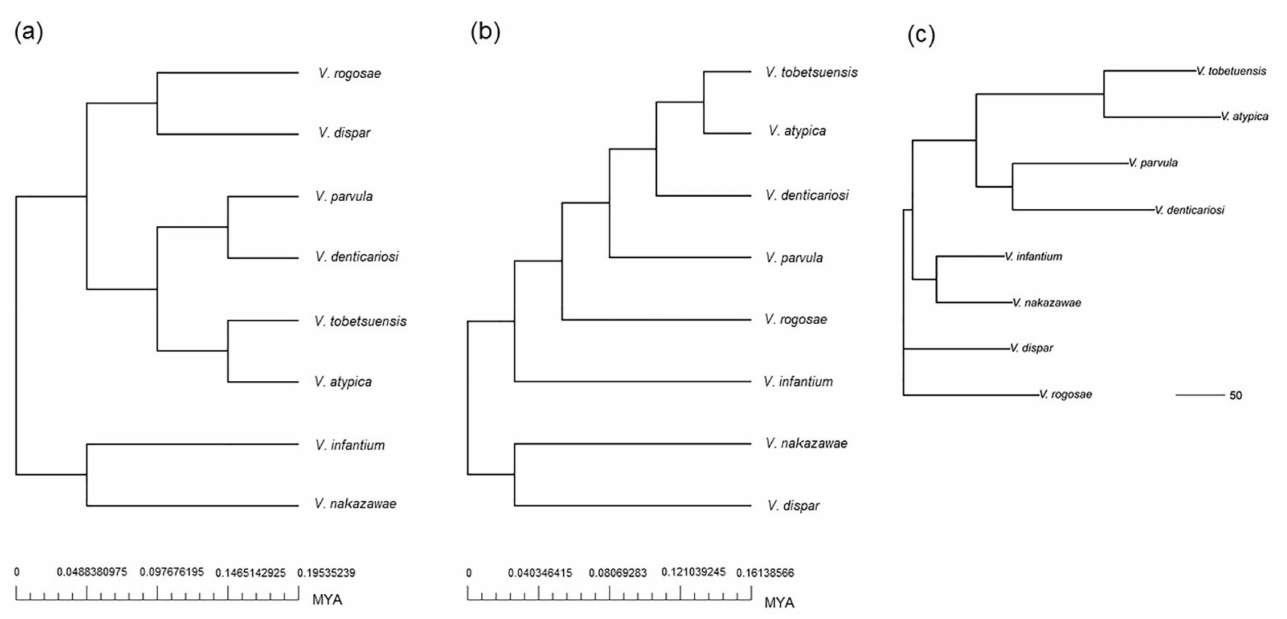
Figure 2. Phylogenetic analysis by BPGA using eight strains of oral Veillonella . A time scale is depicted in millions of years ago (MYA). ( a ) Pan-genome, ( b ) core genomes, ( c ) accessory genomes: this phylogenetic tree was constructed by using the binary matrix presented accessory gene presence/absence (1/0) in each genome. Subsequently, the neighbor-joining (NJ) method was used for the accessory genome binary matrix by ape package v5.5 [50]. The scale bar of NJ tree represents the genetic distance. The distance between two genomes has the number of loci for which they differ, and the associated variance is d (L-d)/L, where L means the number of